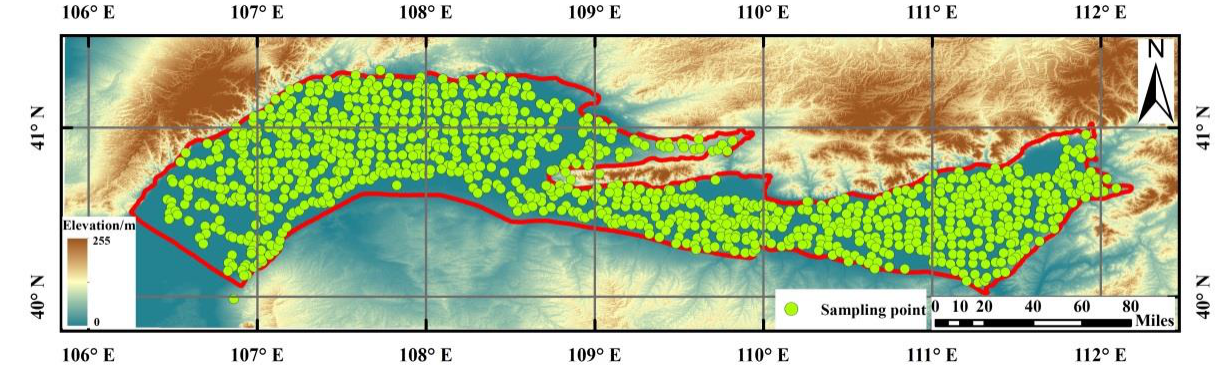
Figure 2. Spatial distribution map of groundwater sampling points in the study area.